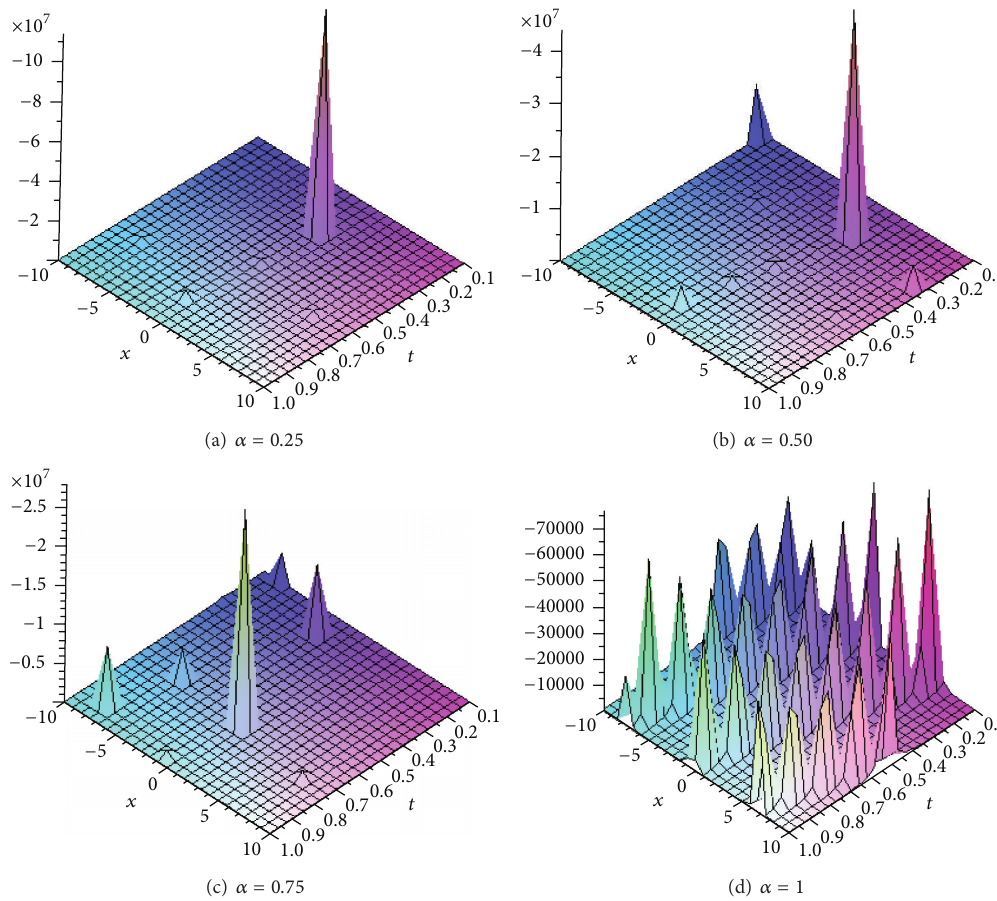
Figure 4: (a)–(d) show singular periodic traveling wave solution of 𝑢 12 3 for different values of parameters.